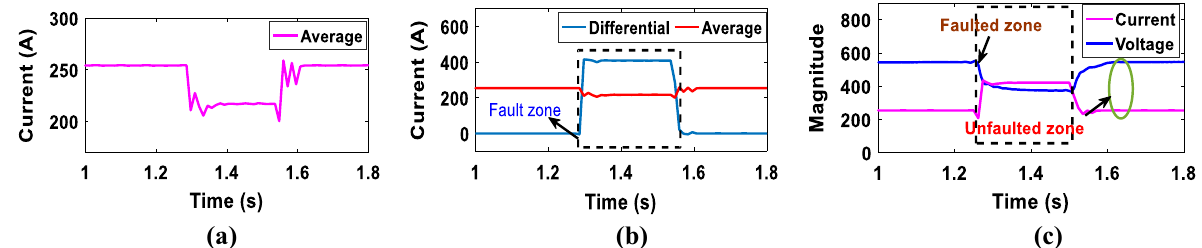
Fig. 5 Cable currents under fault condition a average current, b average versus differential current, c current versus voltage